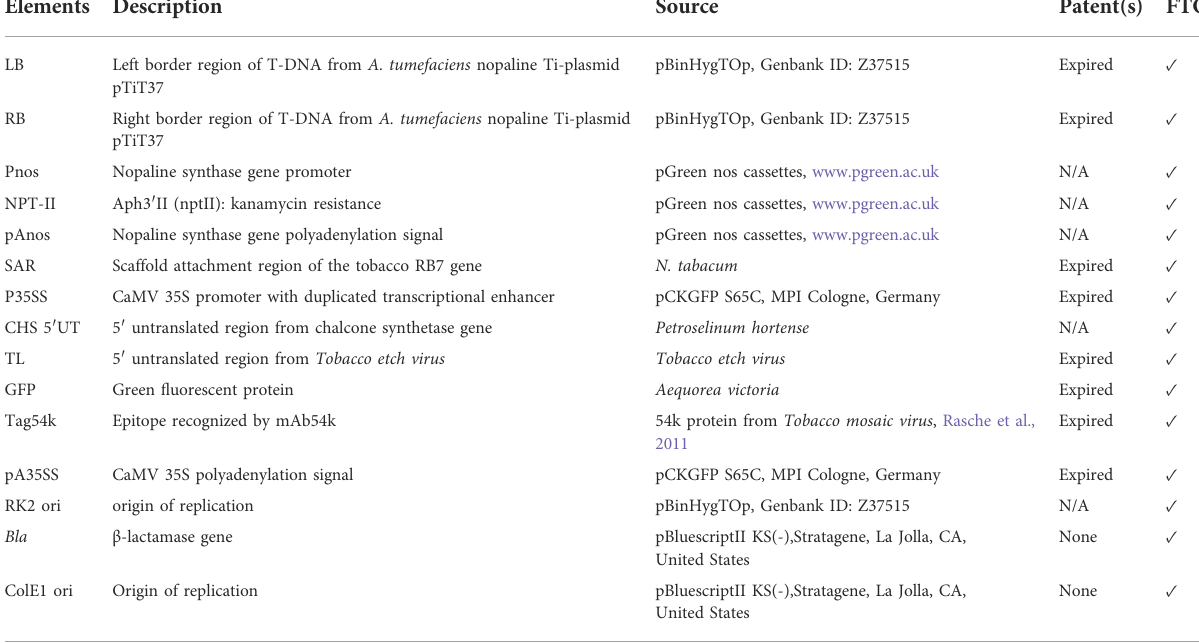
TABLE 1 Summary and analysis of pAIX-c genetic elements. N/A: Not applicable. Elements Description Source